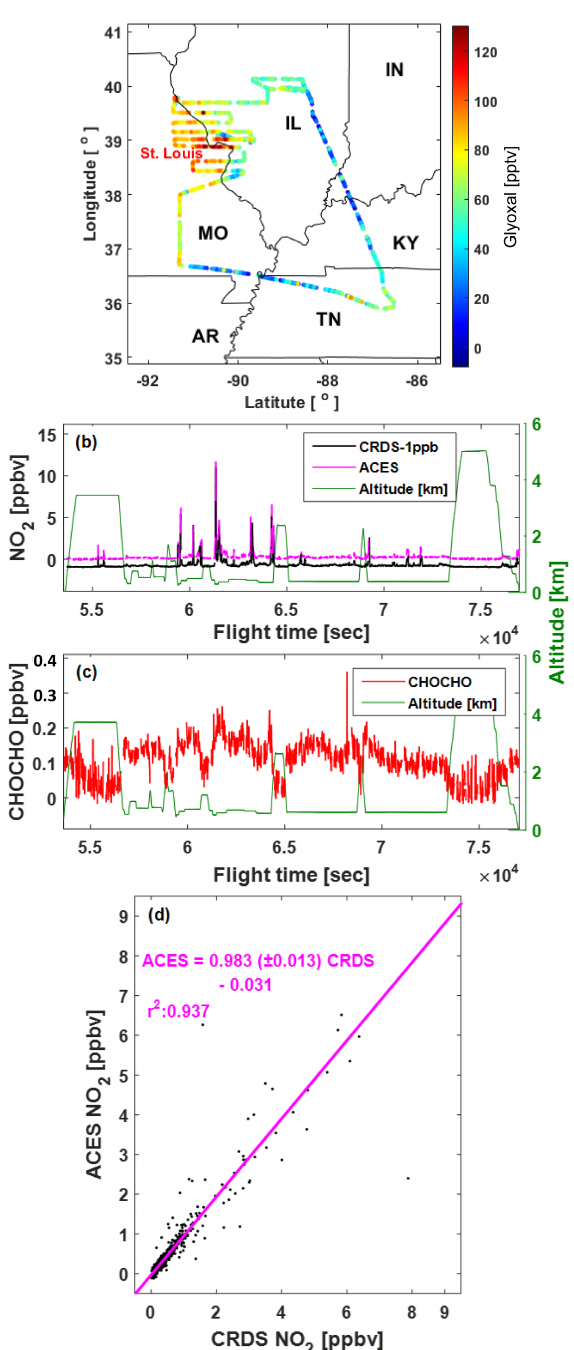
Figure 11. Data from a SENEX 2013 research flight over the cen- tral US that included areas with high isoprene and anthropogenic emissions (Ozark Mountains, MO; St. Louis, MO; Decatur, IL). (a) Flight map showing measured CHOCHO concentrations ac- cording to color scale. (b, c) Time series of NO 2 and CHOCHO, shown with aircraft altitude. NO 2 measured by CRDS is decreased by 1ppbv for clarity. (d) Scatter plot of ACES and CRDS NO 2 data, averaged to 10s. The slope is 0.983 ± 0.013 with r 2 =